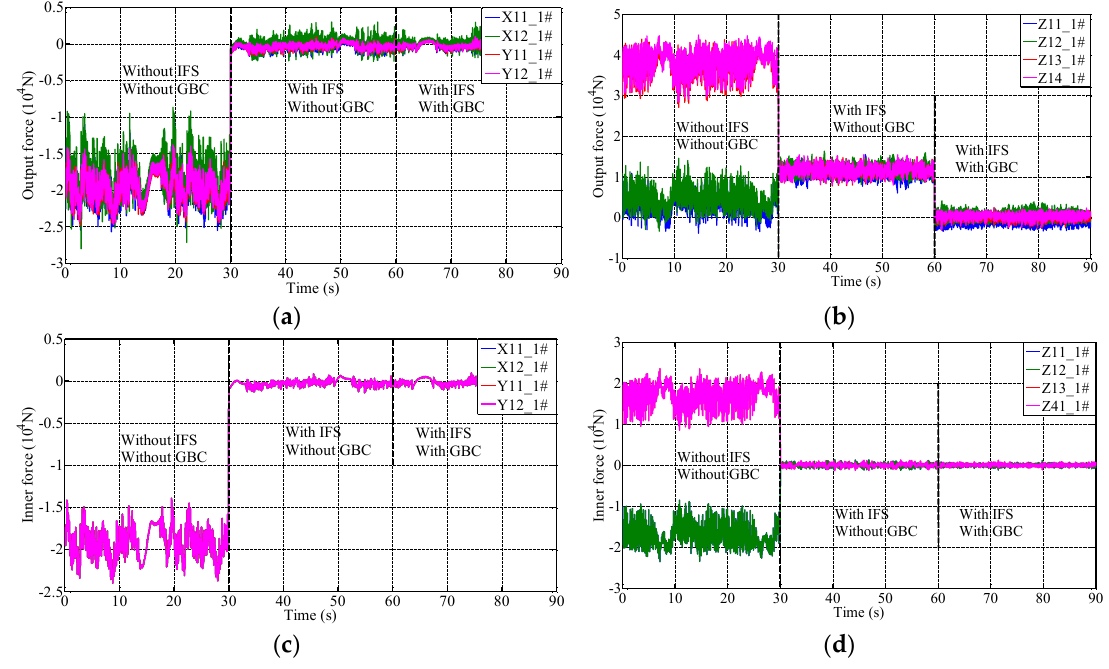
Figure 16. The output forces and inner forces under random signals. ( a ) The horizontal output forces; ( b ) The vertical output forces; ( c ) The horizontal inner forces; ( d ) The vertical inner forces. Table 2. The maximum inner forces and output forces with different controllers at 0 position. Without Inner Force Suppression Output Forces/Inner With IFS, With IFS, Output Forces/Inner (IFS), Gravity Balance Control without GBC GBC Forces (GBC) Horizontal output forces 2.8 × 10 4 N 500 N 500 N Horizontal inner forces 2.6 × 10 4 N Vertical output forces 4.8 × 10 4 N Vertical inner forces Table 3. The maximum inner forces and output forces with different controllers under random signals. Output Forces/Inner Forces